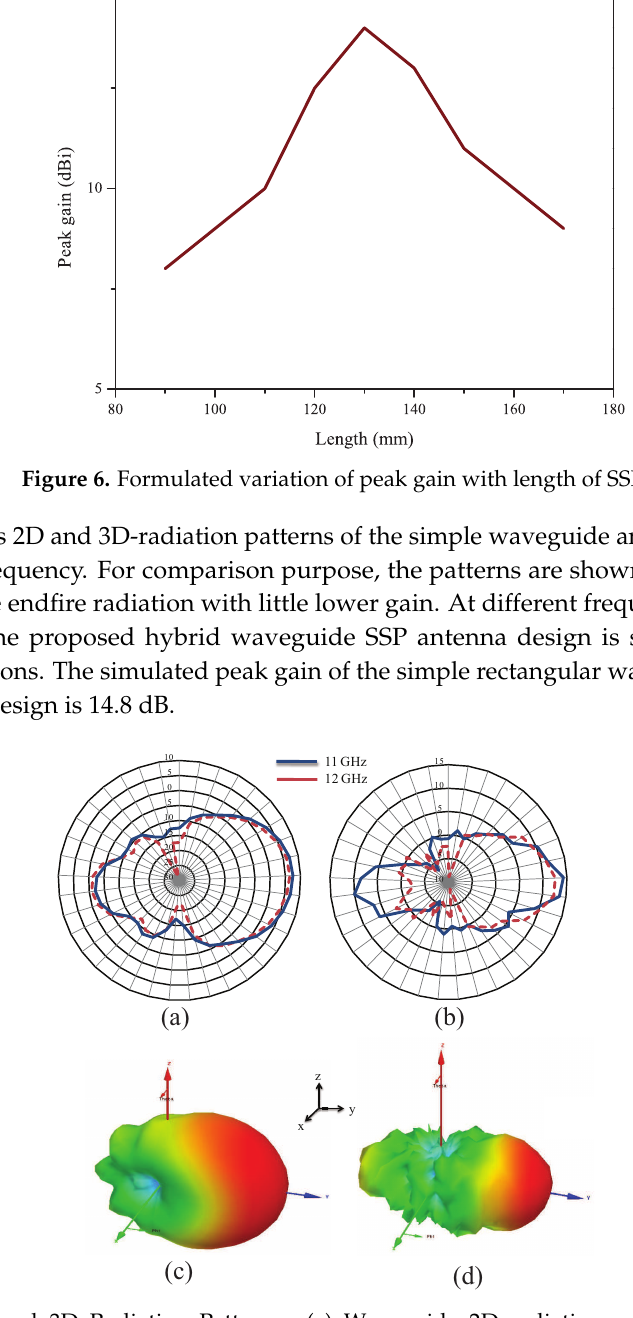
Figure 7. 2D and 3D Radiation Patterns: ( a ) Waveguide 2D radiation pattern, ( b ) Proposed waveguide-SSPP 2D radiation pattern, ( c ) Waveguide 3D radiation pattern, and ( d ) Proposed waveguide-SSPP 3D radiation